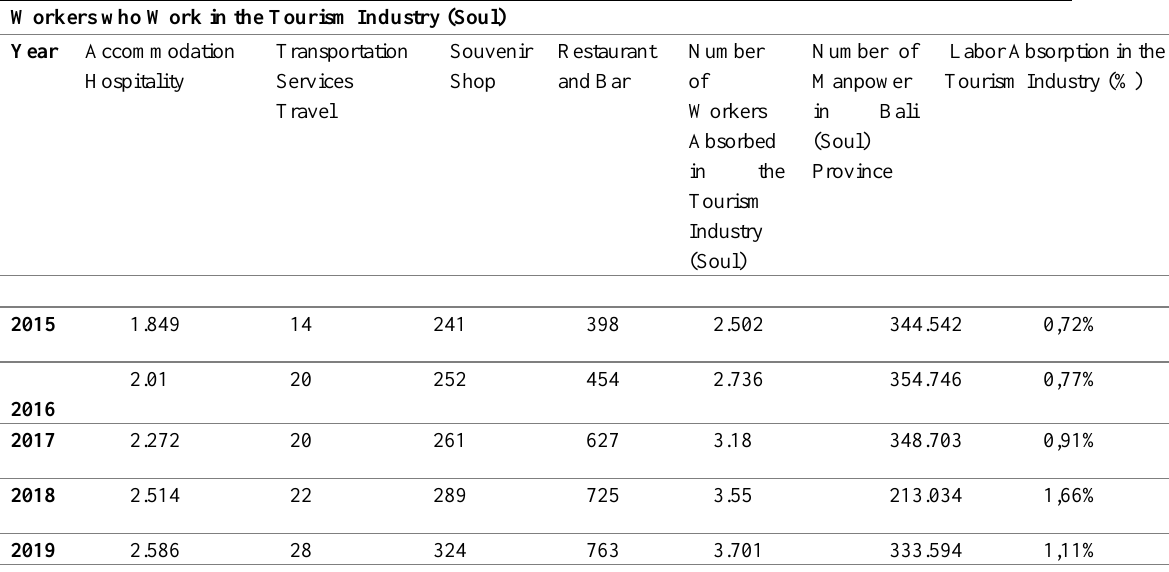
Table 1: Development of Labor Absorption in Bali Province in the Period of 2015-2020. Workers who Work in the Tourism Industry (Soul)